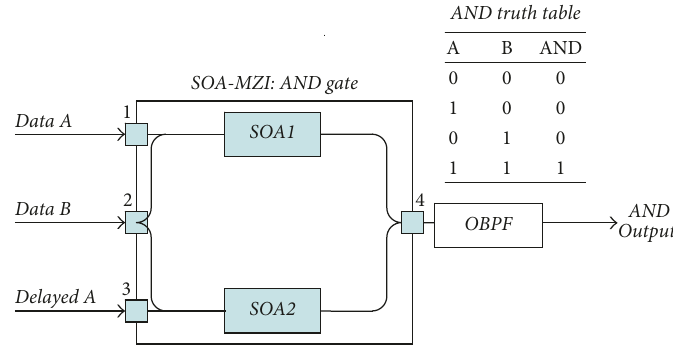
Figure 1: Schematic diagram and truth table for AND operation based on